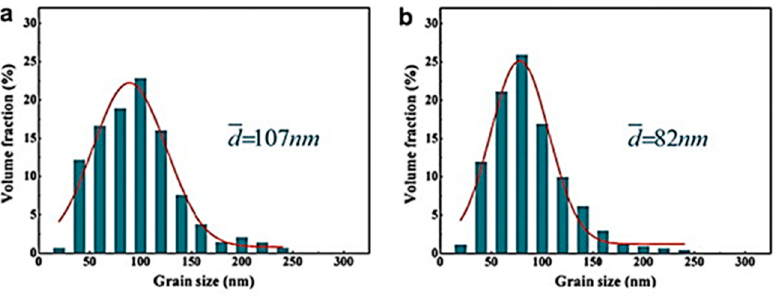
Figure 15. The statistic grain size of alloys after four-pass pressing measured by TEM: ( a ) Cu–5 at.% Al; ( b ) Cu–8 at.% Al [96]. Reproduced with permission from Elsevier Ltd.